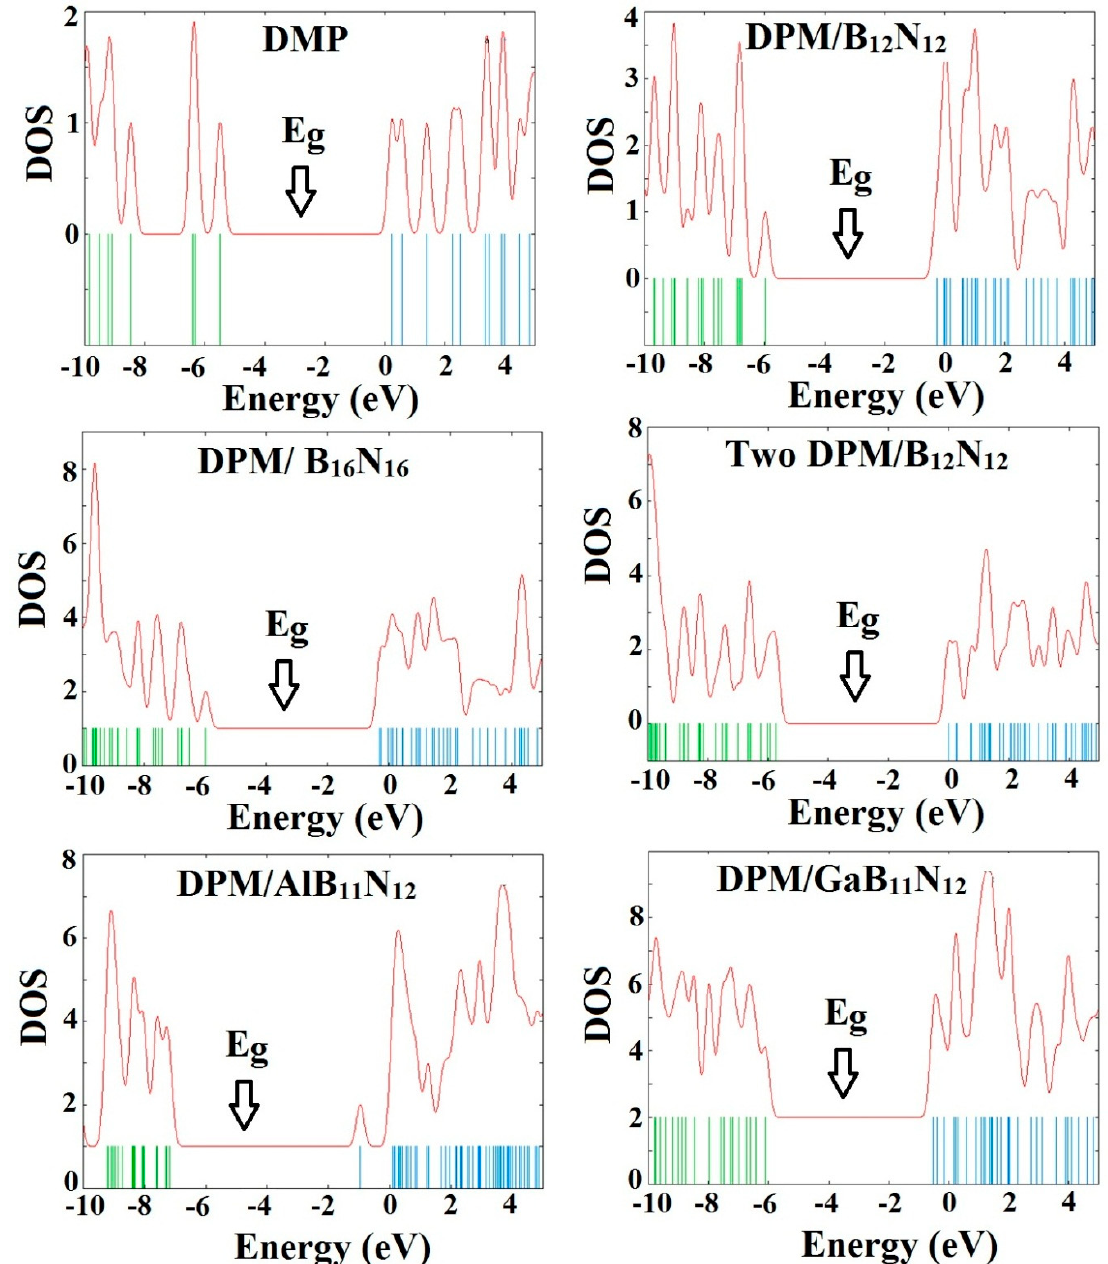
Figure 3. Density of states plots of DPM over the pure, Al- and Ga-doped B 12 N 12 and B 16 N 16 nano-cages.